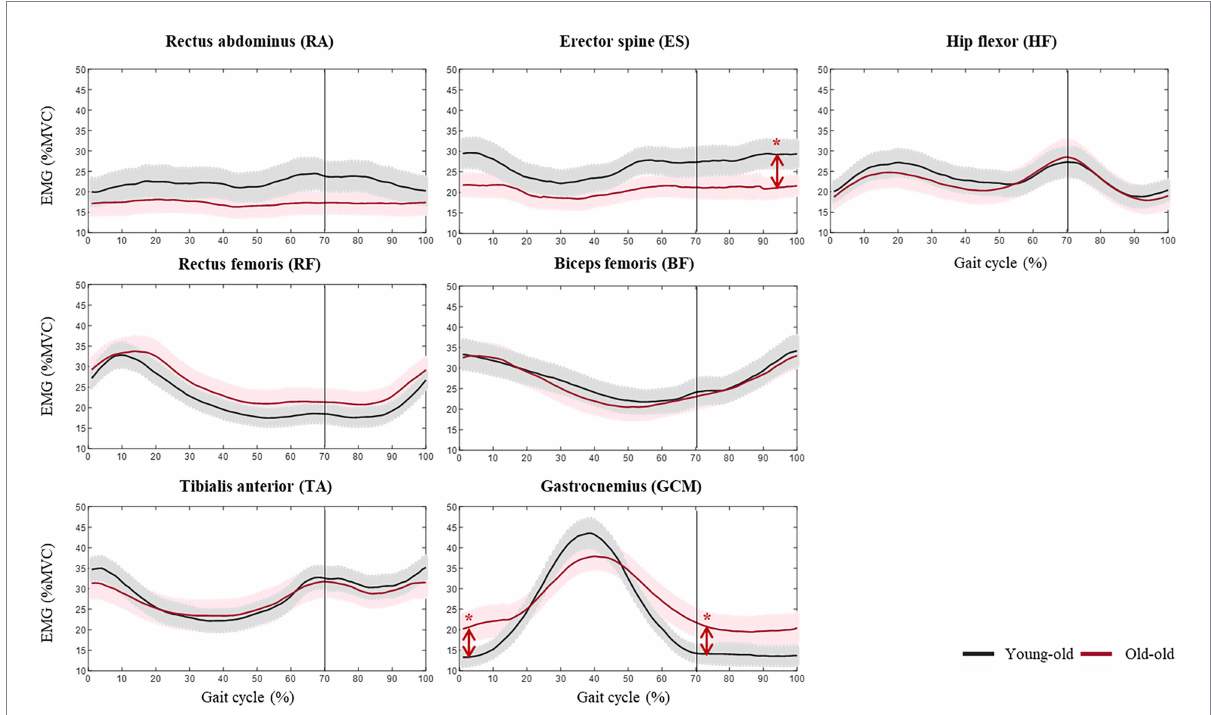
FIGURE 1 Lower limb muscle activity during comfortable walking in the young-old and old-old groups. *Significant difference between groups ( p <